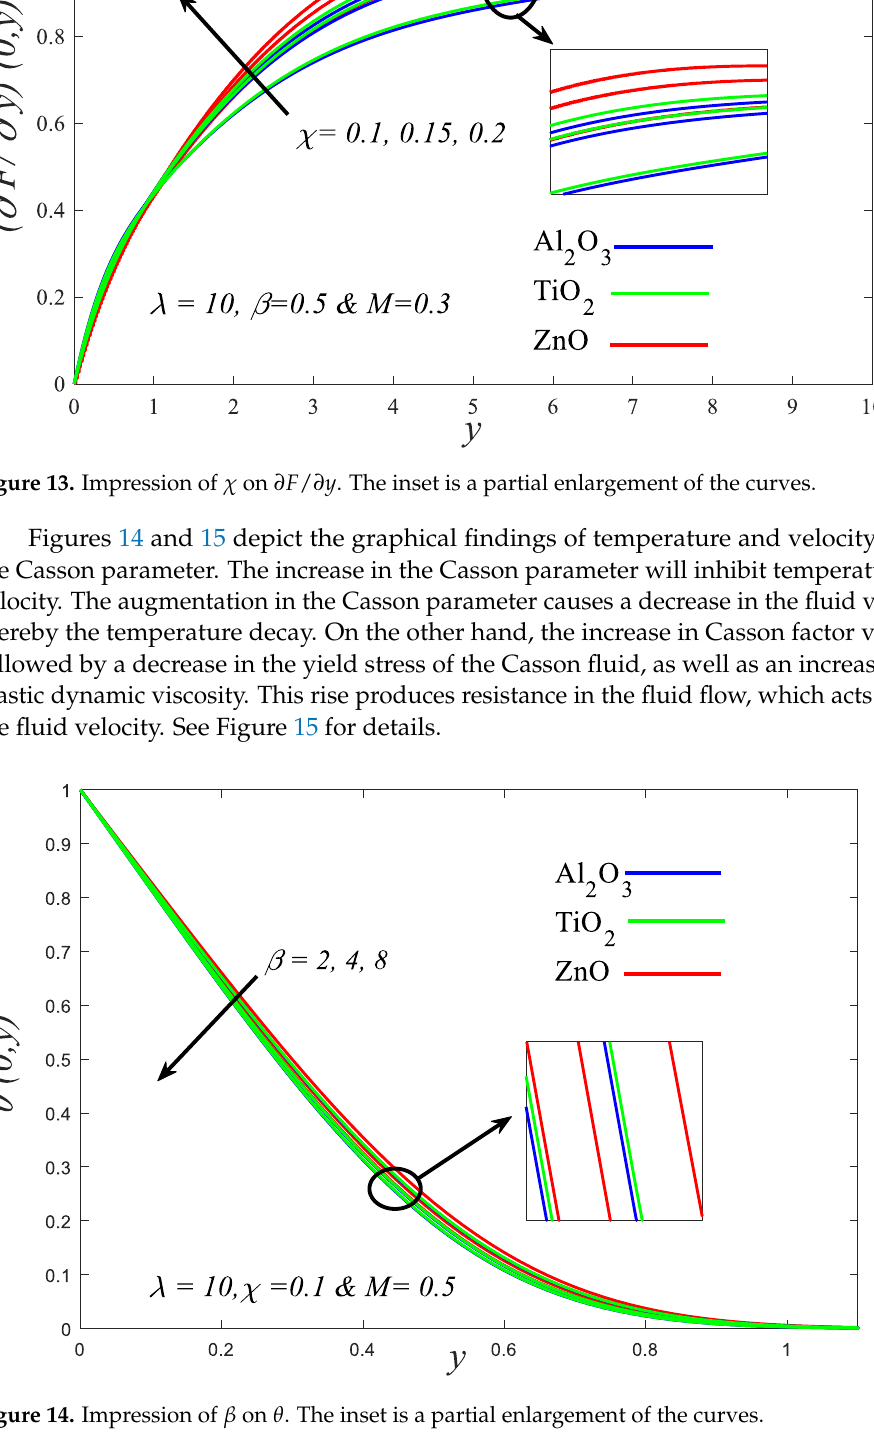
 . The inset is a partial enlargement of the curves.